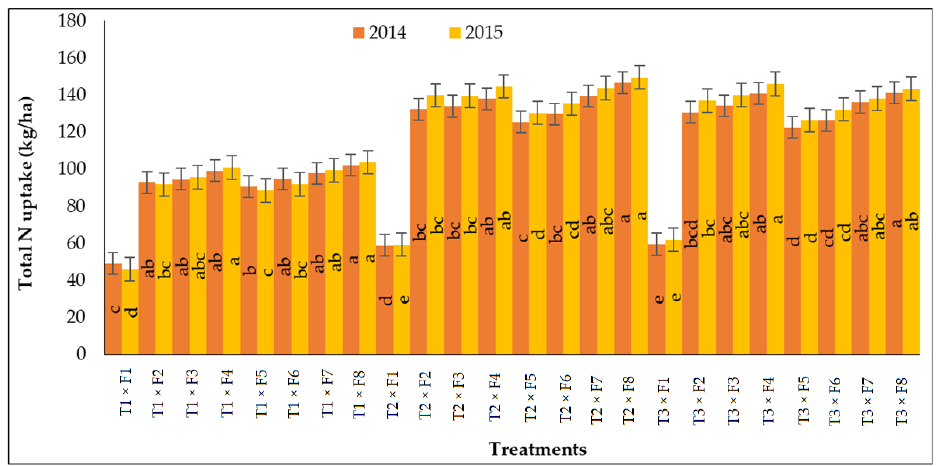
Figure 1. The combined effect of crop establishment methods and integrated nutrient management influence the total N uptake by rice in both years. Treatments details are in Table 1; Within each treatment combination, bars followed by the same lower-case letter(s) indicate significant differences at 5% level of probability. SE ± in each treatment combination was calculated from three replications. Table 2. Crop establishment methods and integrated nutrient management influence the phosphorus contents and phosphorus uptake by